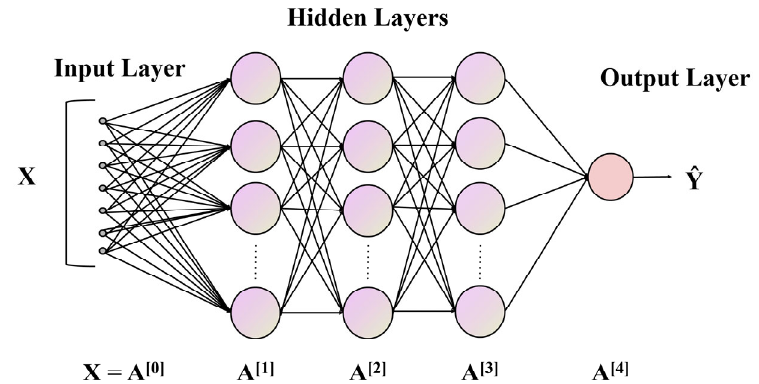
Figure 2. Convolution network structure.